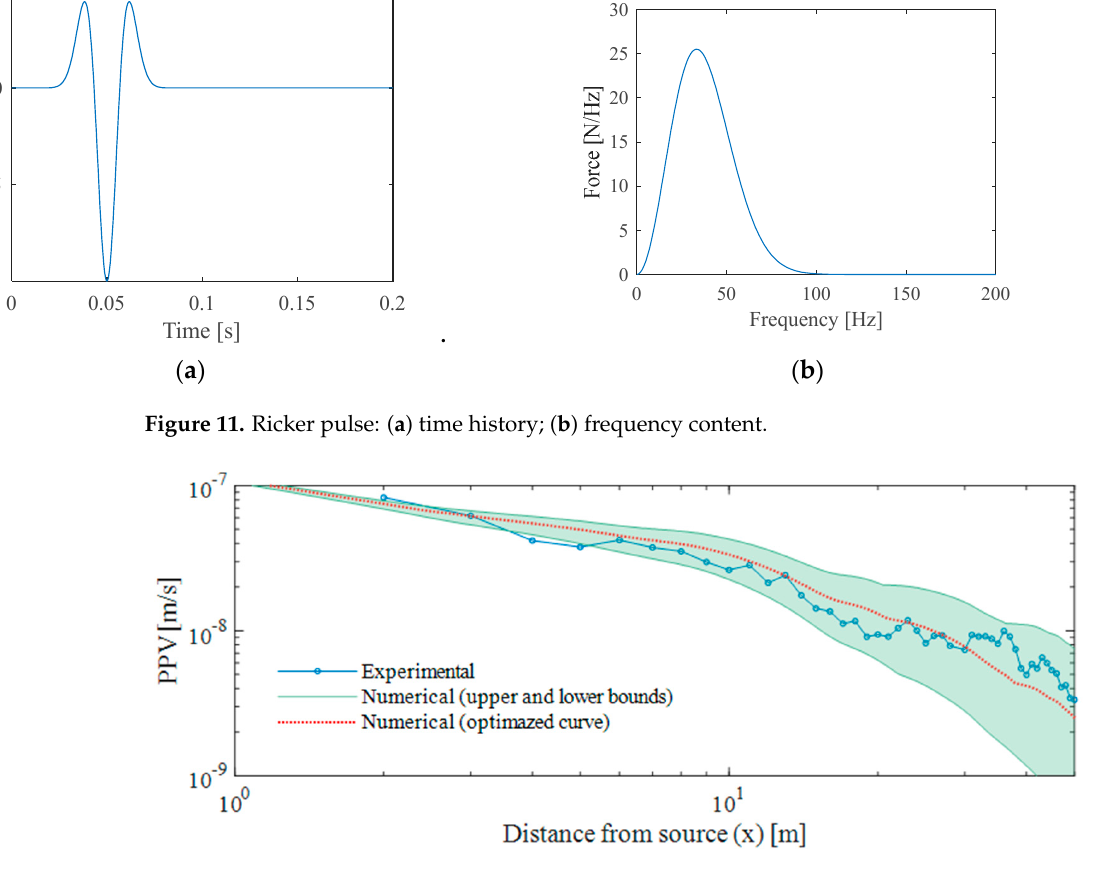
Figure 11. Ricker pulse: ( a ) time history; ( b ) frequency content.